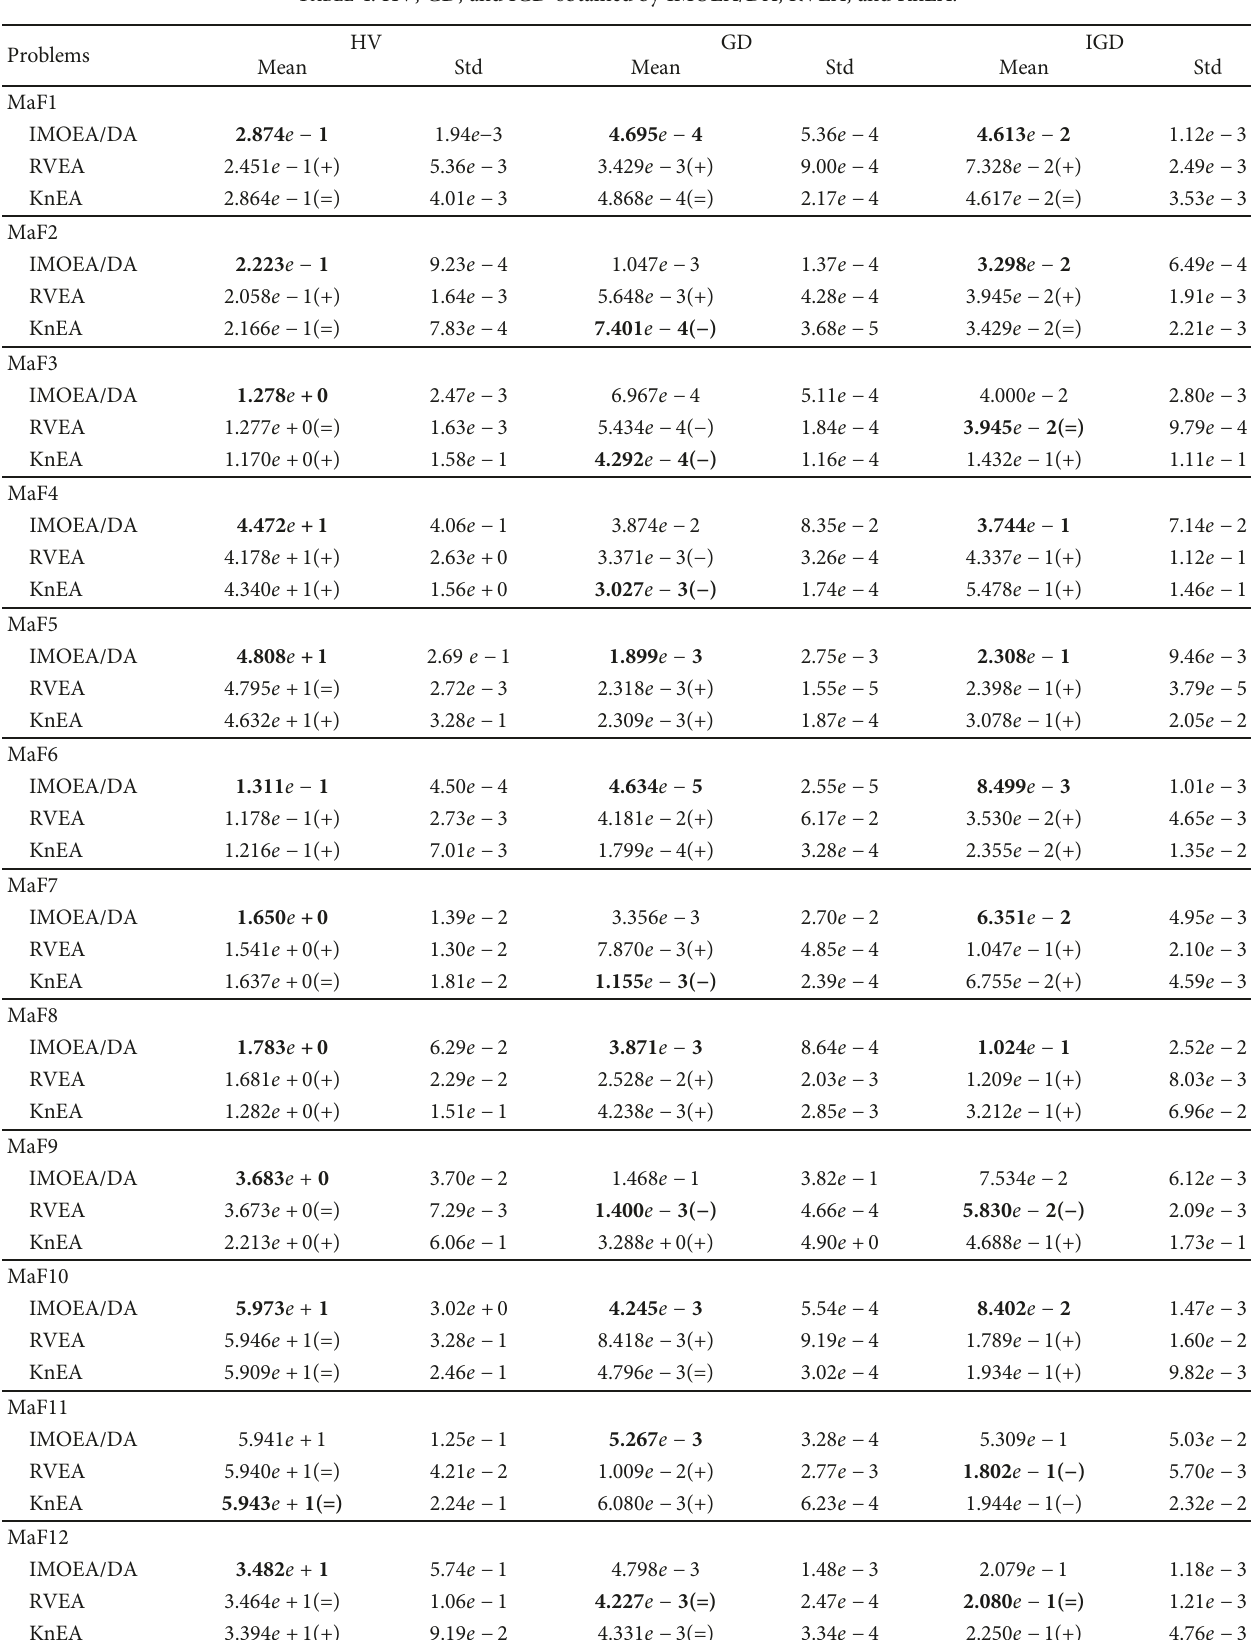
Table 4: HV, GD, and IGD obtained by IMOEA/DA, RVEA, and